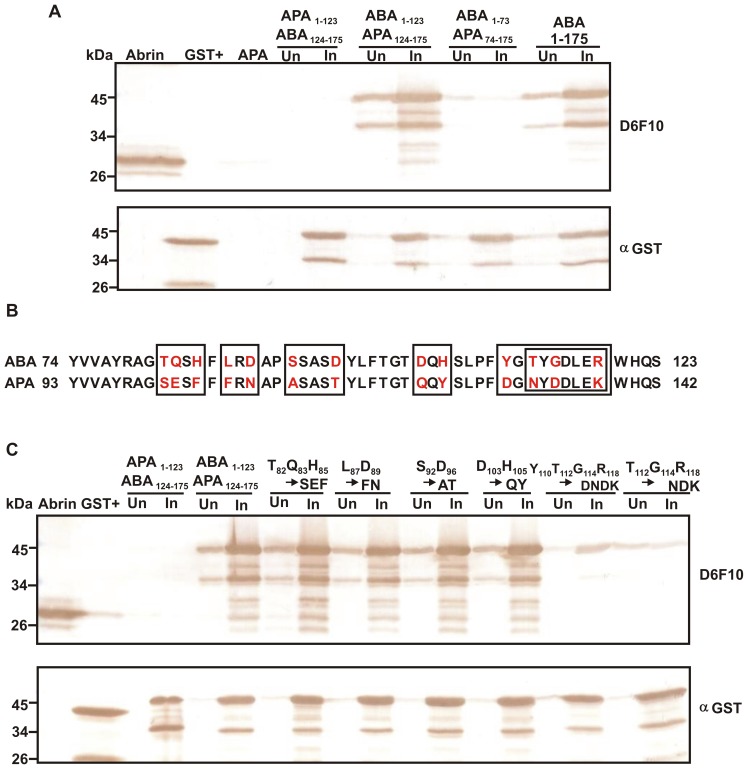
The core epitope corresponding to the mAb D6F10 includes the residues Thr112, Gly114 and Arg118 of ABA.The uninduced (Un) and induced (In) samples of the chimeric proteins (∼45 kDa) of ABA and APA A chain were subjected to immunoblot analysis with mAb D6F10 or anti-GST antibody. (A) The recombinant protein ABA1–123APA124–175 bound the mAb D6F10 whereas no binding was observed with the proteins APA1–123ABA124–175 and ABA1–73APA74–175. (B) Sequence alignment of the amino acids 76–123 of ABA with the corresponding residues of APA A chain. Each box represents one recombinant clone obtained where the ABA residues highlighted in red are mutated to the corresponding amino acids of APA A chain, also highlighted in red. (C) Mutants of the truncated chimeric protein ABA1–123APA124–175 namely, T82Q83H85 to SEF, L87D89 to FN, S92D96 to AT and D103H105 to QY bound the mAb D6F10 whereas the mutants namely, Y110T112G114R118 to DNDK and T112G114R118 to NDK showed very little binding to the antibody.